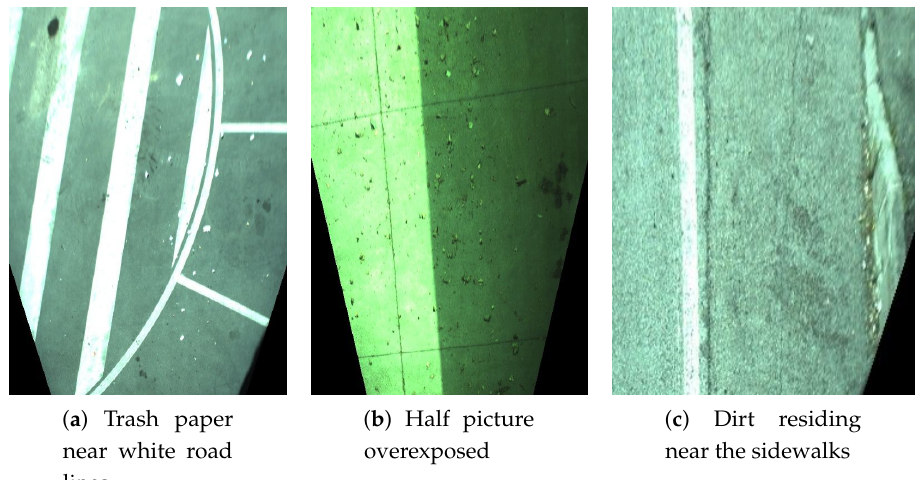
Figure 10. Peculiar situations encountered during the dataset creation. ( a ) A hard condition for the network: it has to detect white pieces of paper near white road lines. The only way to do that is by learning their shapes (through example). ( b )A poorly exposed image. Half of the picture is overexposed, while half underexposed. The network must be trained with such cases in order to work well during inference. Moreover, while it can learn to detect both overexposed and underexposed trash, the best solution to the problem would be equipping the system with a HDR camera. ( c ) A case of valuable a priori knowledge that can be exploited by the system. In fact, dirt usually gathers around nearby sidewalks. With this consideration in mind, the network can be trained to clean the sidewalks by default (by properly preparing the ground truth labels, such as in Figure 6), since finding a sidewalk is much easier than detecting each single cigarette